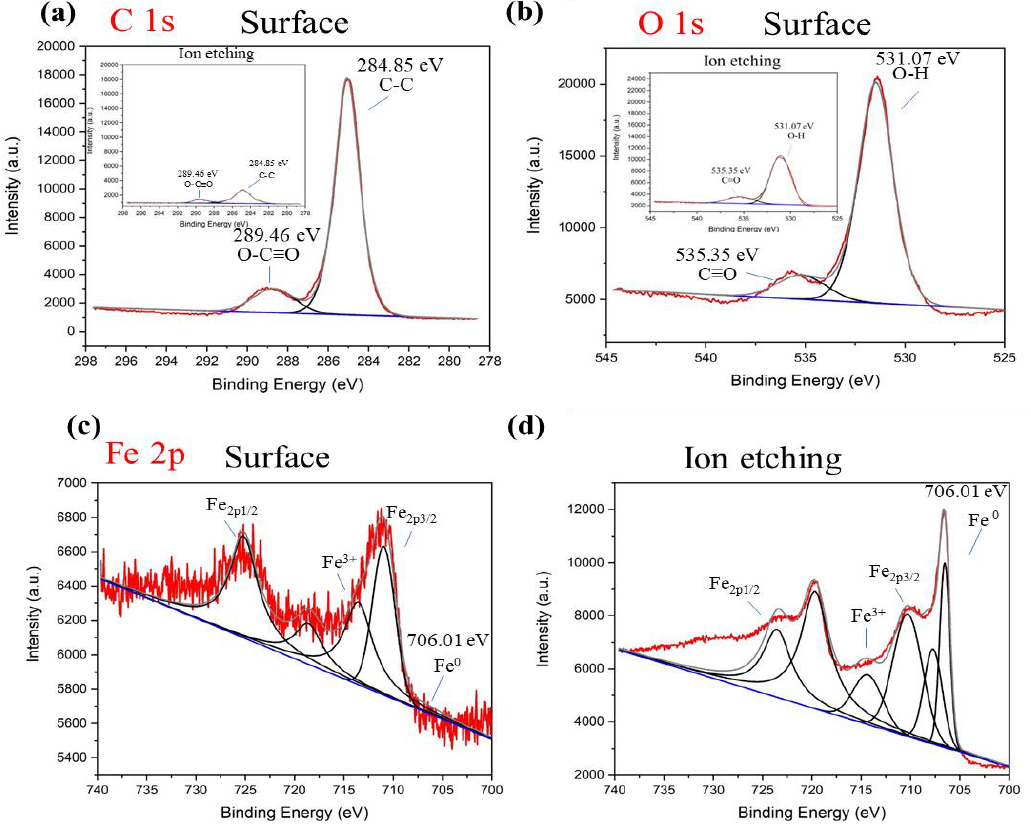
Figure 4. XPS analysis of nZVI/n-lignin: ( a ) C 1s scan, ( b ) O 1s scan, ( c ) Fe 2p scan, and ( d ) Fe 2p scan after argon ion etching. The insets in ( a , b ) are C 1s and O 1s of nZVI/n-lignin after argon ion etching. To identify the presence of nZVI in the lignin, XRD measurements of the bare nZVI, EG-functionalized nZVI, and nZVI/n-lignin were also conducted. A strong peak of lignin was observed at the 2θ scan of 29.4 ° (not shown). As Figure 5a shows, three peaks at the 2θ scan of 44.9 °, 65.0° and 82.3° are clear for the XRD result of the bare nZVI, which indi- cate the iron crystal orientations of (110), (200), and (211) planes, respectively [31,32]. In Figure 5b, the noise of the XRD spectra increases due to the smaller size of the EG-func- tionalized nZVI. Moreover, the XRD analysis of nZVI/n-lignin is shown in Figure 5c. A broad peak in the noisy XRD spectrum is observed near 44.9°, indicating the presence of nano- sized α -Fe 0 due to the formation of the composite with three-dimensional-branched lignin in the EG solution.